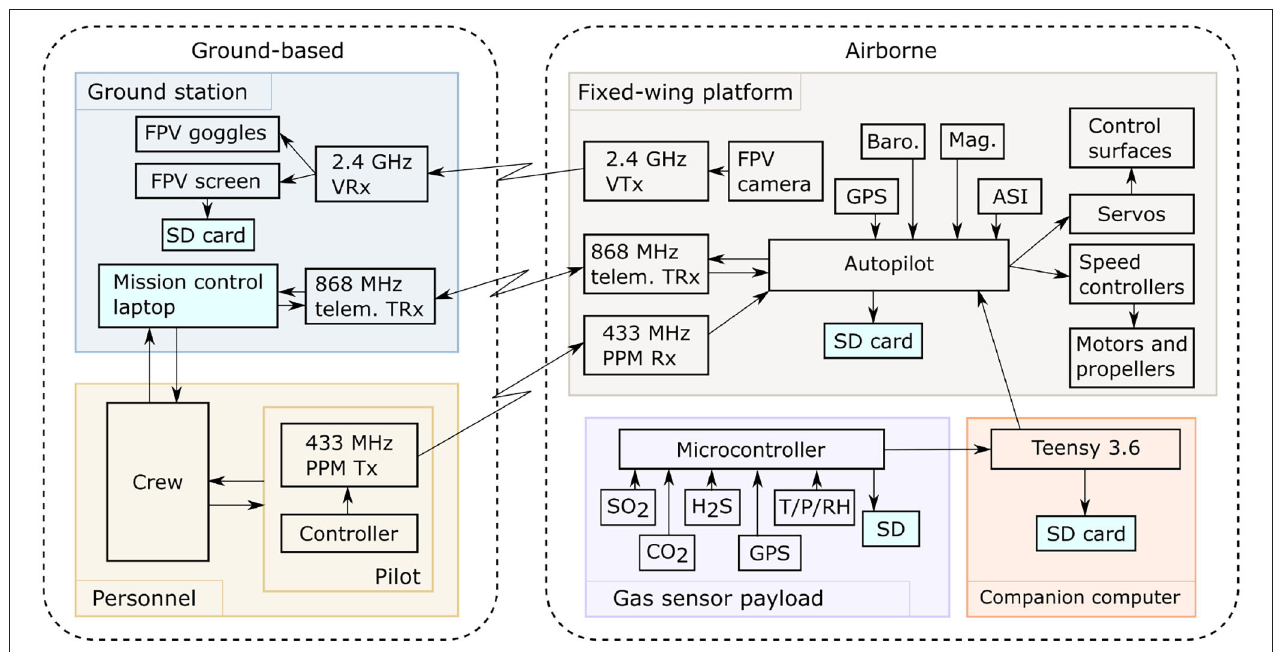
FIGURE 3 | Interconnection of the UAS sub-systems. Live sensor data is relayed from the sensors, via the companion computer, autopilot, and ground station before being displayed live to allow guidance during FBW flight segments.